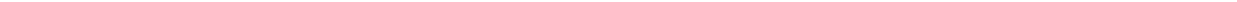
Fig. 2 Genomic expansion and the expression of Harbinger DNA transposable elements pluripotency miRNAs and salamander-speci fi c methyltransferases during adult limb regeneration in P. waltl . a Portion of Gypsy and Harbinger repeats ( > 1 kb) retaining a detectable protein domain. b Phylogeny of Gypsy and Harbinger elements. While the tree-based on Gypsy elements indicates a uniform expansion, the tree-based on Harbinger elements shows three branches (brown) resulting from a second distinct burst. The second Harbinger burst also results in a bimodal pairwise genomic distance distribution, compared to a unimodal distribution for the Gypsy elements. c Phylogenic tree of 361 mature P . waltl miRNAs with miR-427 and miR-93b expansion highlighted (top). Sequence logo based on multiple alignment of 155 miR-427 sequences and 66 miR-93b sequences (bottom). Note the embryonic stem cell-speci fi c cell cycle regulating seed AAGUGC within the fi rst eight nucleotides. d Split violin plot showing the tau score distribution of P . waltl genes that have non-salamander vertebrate orthologs (blue) and genes that only have salamander orthologs (beige). e RNAseq quanti fi cation of fi ve Harbinger orthology groups encoding Myb or Harbi domain-bearing proteins (top), four Gypsy orthology groups encoding reverse transcriptase domain-bearing proteins (middle) and mir-427 and mir-93b primary transcripts (bottom). In parentheses are the number of transcripts and gene models belonging to each group. The groups chosen were signi fi cantly upregulated in the regenerating limb 3 days post amputation (dpa). Differential expression calculated by DESeq2 (Supplementary Table 9). TPM transcripts per million. f Eleven orthology groups of salamander methyltransferase are expressed speci fi cally in appendages of the adult animal. In parentheses are the number of transcripts and gene models belonging to each